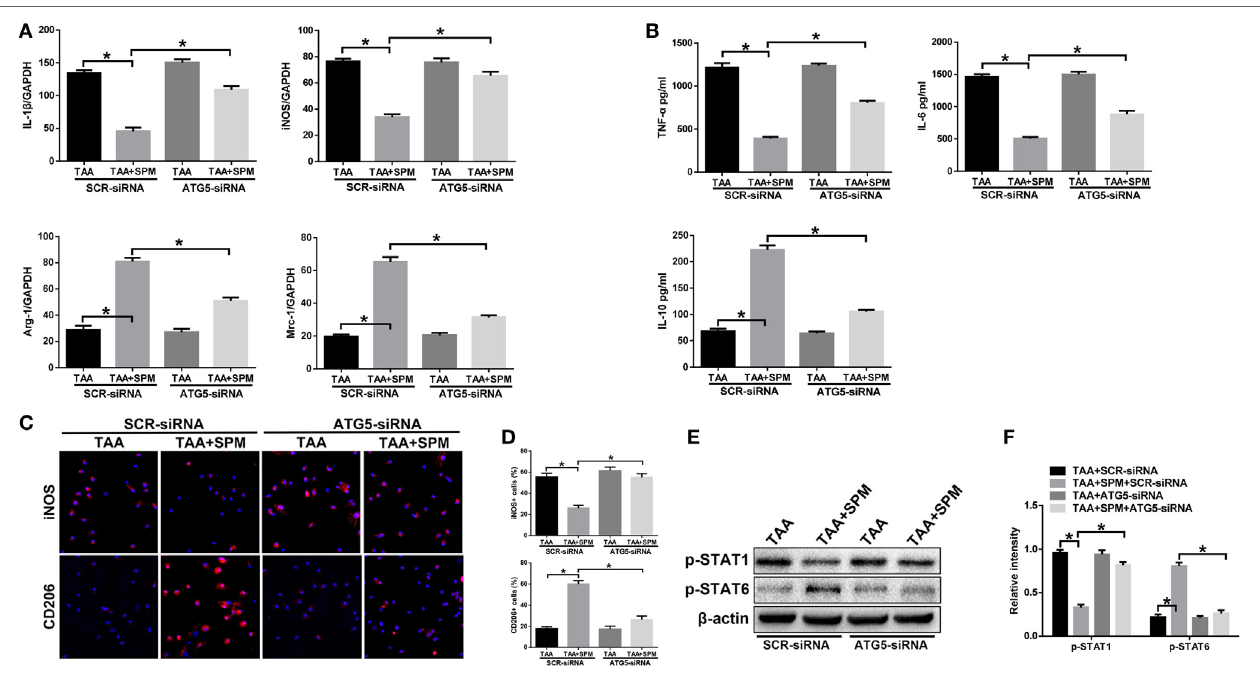
FigUre 5 | Spermine (SPM) regulates KC M1/M2 polarization in response to thioacetamide (TAA) treatment in an autophagy-dependent manner. Mice were subjected to SPM pretreatment and TAA administration as described in Section “Materials and Methods.” Both TAA and TAA + SPM mice were pretreated with ATG5 siRNA (ATG5-siRNA) or its scrambled control siRNA (SCR-siRNA) in vivo prior to TAA administration using mannose-conjugated polymers as described in Section “Materials and Methods.” KCs were isolated from different groups. M1 markers ( IL-1 β and iNOS ) and M2 markers ( Arg-1 and Mrc-1 ) were measured by quantitative RT-PCR. Representative of three experiments (a) . Isolated KCs from different experimental groups were cultured for 6 h, and TNF- α , IL-6, and IL-10 protein were measured in the culture supernatant by ELISA [ (B) , n = 3/group]. Immunofluorescence staining of iNOS and CD206 in KCs (original magnification 20 × ). DAPI was used for nuclear staining [ (c) , n = 3/group]. Ratio of iNOS + and CD206 + cells in different experimental groups [ (D) , n = 3/group]. Intracellular p-STAT1, p-STAT6, and β -actin protein levels were measured by Western blot. Representative of three experiments (e) . Relative density ratios of target proteins in different experimental groups compared to the control group (CON-SCR-siRNA) were calculated [ (F) , n = 3/group] (* p <